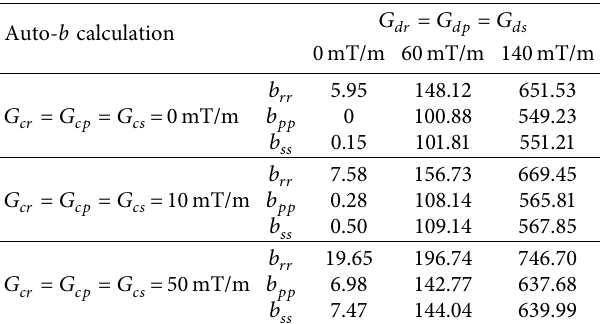
Figure 4: Illustration of a conventional SE imaging sequence (a) and a simulation protocol (b). In the simulation protocol, the variables i , t G i , and δ i denote the type, start time, amplitude, and duration of the i th gradient pulse, respectively. Te trapezoidal ramps have a uniform time of 200 μ s. G rdp represents the read-dephasing gradient; G dr , G dp , and G ds represent difusion-sensitizing gradients in the read, phase, and slice directions, respectively; G cr , G cp , and G cs represent crusher gradients in the read, phase, and slice directions, respectively. Table 4: Te diagonal elements of the b -matrix (unit: s/mm 2 ) calculated by Auto- b